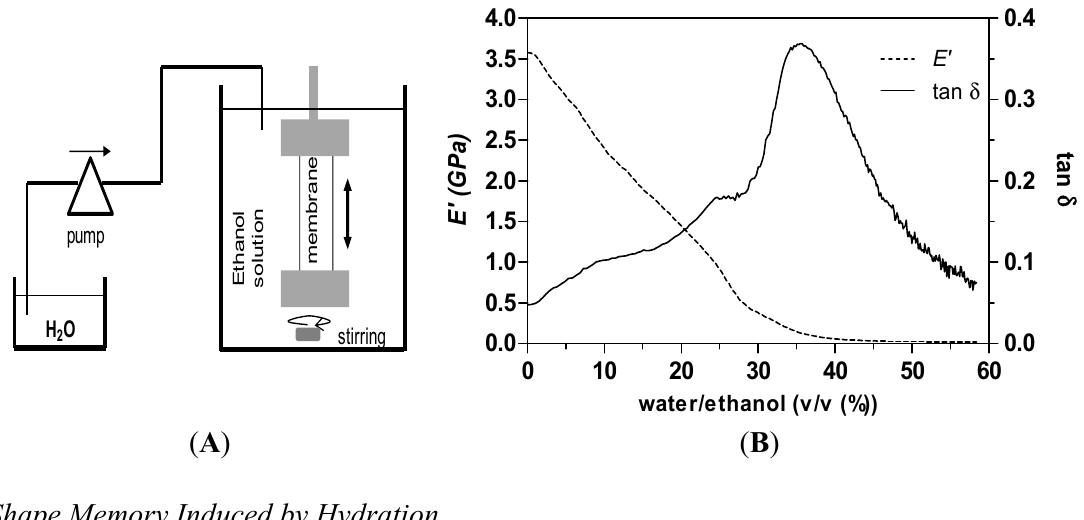
Figure 3. ( A ) Schematic representation of the Dynamic Mechanical Analysis (DMA) experiment performed where the chitosan membrane was clamped in the DMA apparatus and immersed in an ethanol bath. After a certain period of time, water was added to the ethanol bath in a controlled manner to vary the water/ethanol composition of the bath. ( B ) Apparent storage modulus ( E ′ ) and loss factor (tan δ ) at room temperature measured with samples immersed in water/ethanol mixtures as a function of water